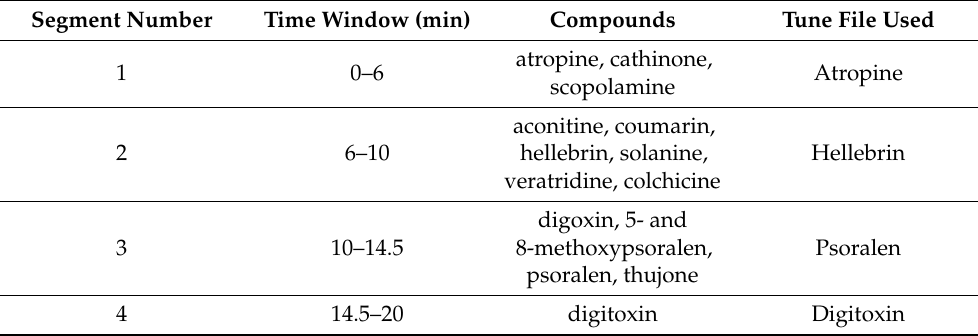
Table 3. Breakdown of MS/MS method per